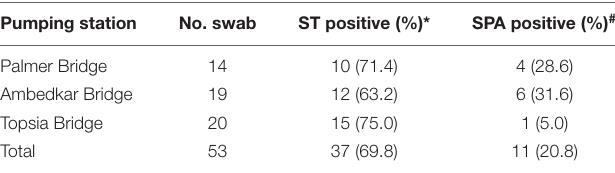
TABLE 4 | ST and SPA detection between September 2019 and March 2020 in Moore swab samples from three pumping stations in Kolkata,